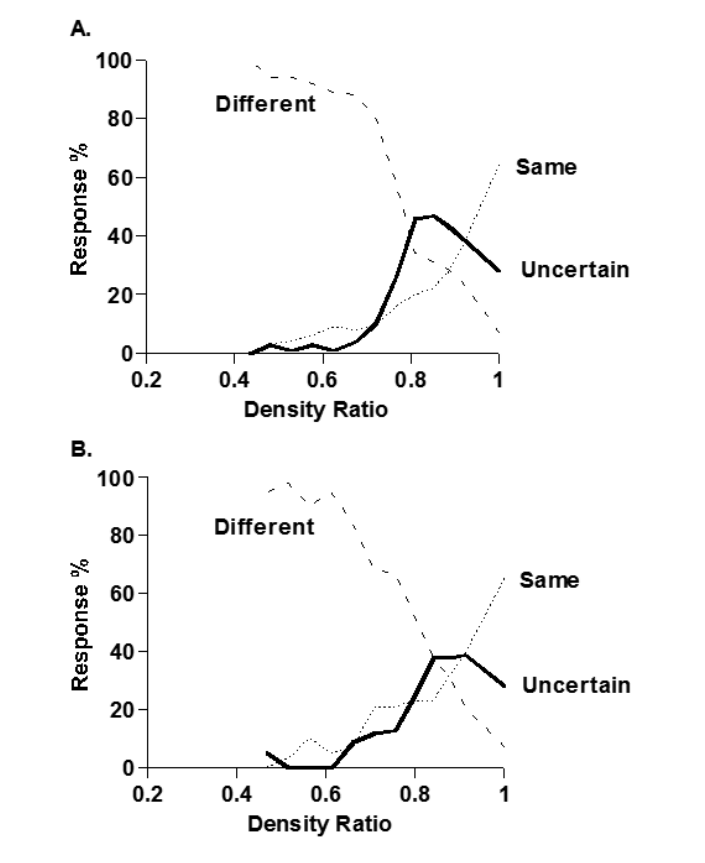
Figure 2. Composite performance by ( A ) six humans and ( B ) two monkeys in a same-different task. The horizontal axis gives the ratio between the densities of the comparison box and the standard box for trials of different disparities. The same response was correct for trials at a proportional box disparity of 1.0. These trials are represented by the rightmost data points. All other trials required the different response. The solid line represents the percentage of trials receiving the uncertainty response at each density ratio. The percentages of trials ending with the different response (dashed line) or same response (dotted line) are also shown. From “Uncertain Responses by Humans and Rhesus Monkeys ( Macaca mulatta ) in a Psychophysical Same-Different Task,” by W. E. Shields, J. D. Smith, and D. A. Washburn, 1997, Journal of Experimental Psychology: General , 126 , p. 158. Copyright 1997 by the American Psychological Association. Reprinted with